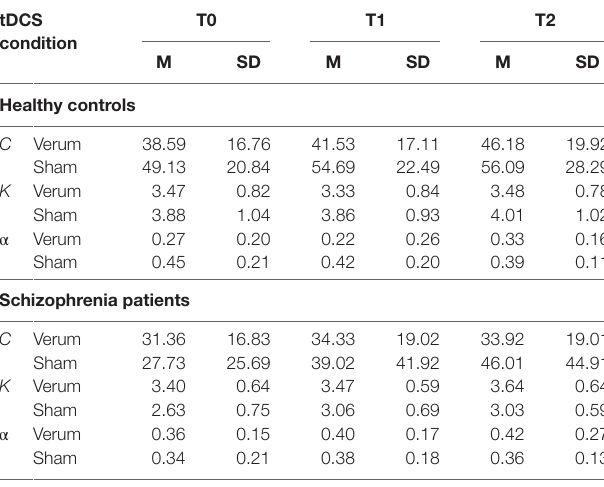
TaBlE 4 | Theory of Visual Attention whole- and partial-report parameters in the healthy control and schizophrenia patient groups for the three time points (T0, T1,